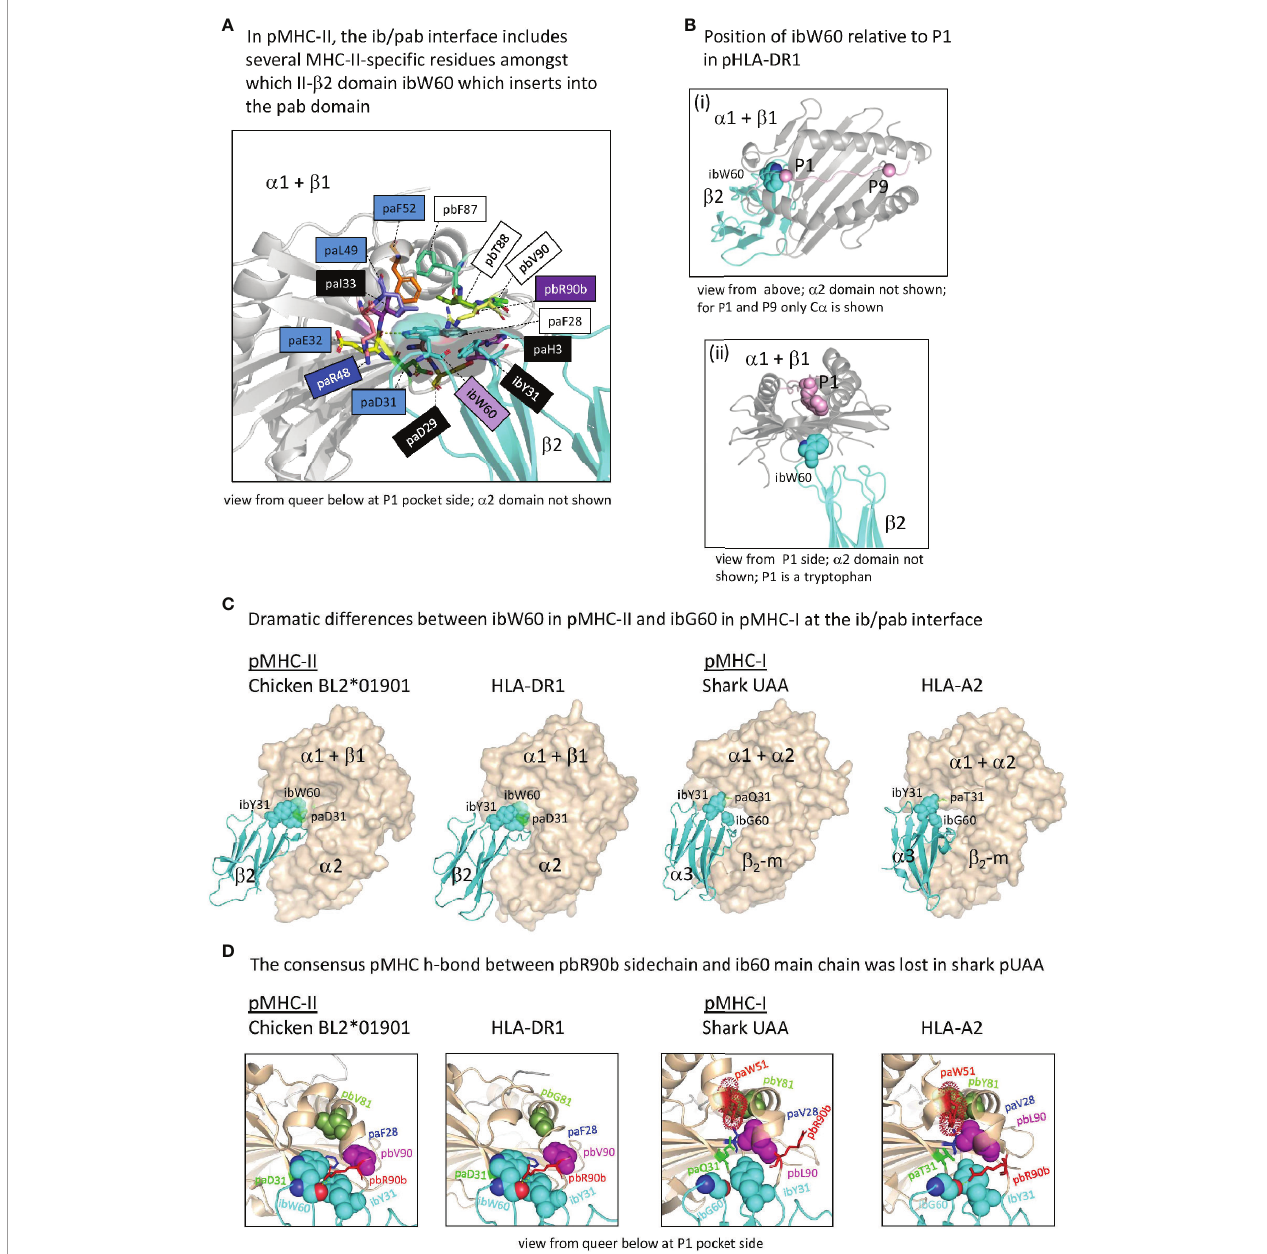
FIGURE 8 | The interface between the ib and pab domains. (A) Shown here for pHLA-DR1, the MHC-II b -speci fi c residue ibW60 residue together with the more ancient residue ibY31 forms a knob (indicated in sticks format plus transparent surface presentation) which inserts into the pab domain. Pab residues surrounding this knob, and also paH3 as being part of the paH3/paF28/paD29 interaction [ Figure 5D (c)], are highlighted in sticks format. Residue ibW60 makes polar contacts with paD31 and paE32. Color shading of residue names, as in Figure 7B (a), refers to conservation patterns (see above and Supplementary File 1A ), with light purple used for MHC-II b -characteristic residues. (B -i) and (B -ii) help to understand the position of pHLA-DR1 ibW60 (sidechain in spheres format) relative to the pab groove and the P1 residue. (C) At the position where pMHC-II possesses the very large ibW60, in pMHC-Is the very small ibG60 tends to be found (together with ibY31 indicated in spheres format). Whereas in pMHC-IIs the sidechain of a characteristic paD31 residue makes a polar contact with the ibW60 main chain, in pMHC-Is a variety of residues is found at pa31 (green). The pa+pb+ia domains are indicated in wheat color transparent surface format and the ib domains are indicated in cyan color cartoon format. (D) Shared between most elucidated pMHC-IIs and pMHC-Is is a polar contact between pbR90b sidechain and ib60 main chain, but in shark pUAA this contact was lost. Some other residues characteristic for this region in either pMHC-II or pMHC-I, and their counterparts in the other MHC class, are highlighted in several manners, with only ib60 coloring based on